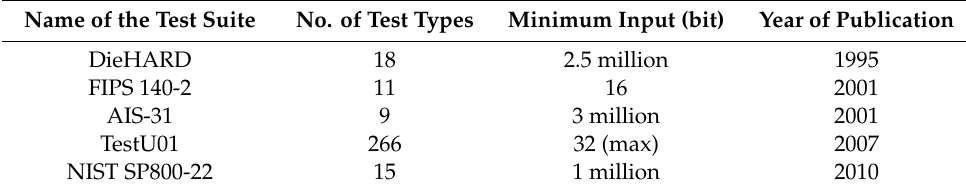
Table 2. Minimum Input for Di ff erent RNG Test